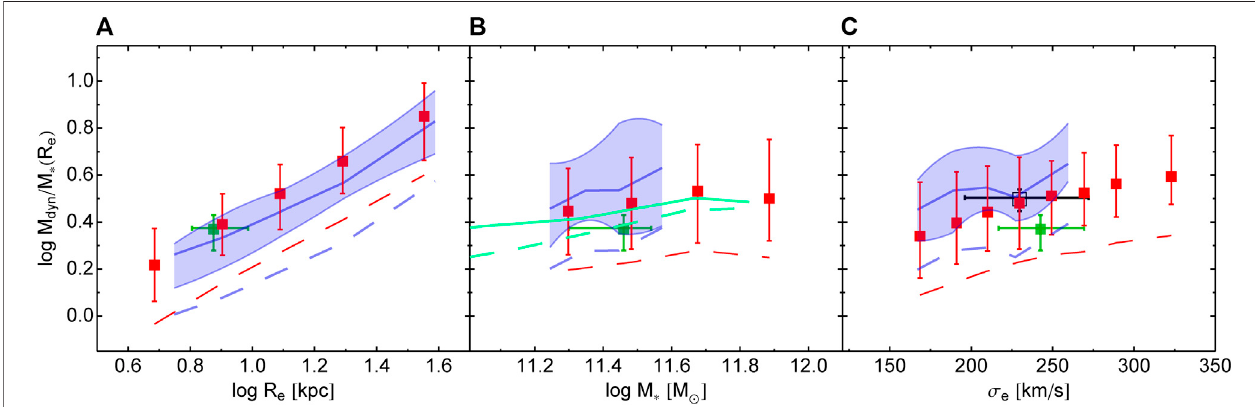
FIGURE1| Thetotal-to-stellarmassratio M dyn / M p withineffectiveradius, R e ,assumingaChabrierIMF,asafunctionof R e (A) ,totalstellarmass M p (B), andvelocity dispersionwithineffectiveradius σ e (C) .Linescorrespondtomedians,andshadedregionsorerrorbarstothe25 – 75thpercentile.Redsquareswitherrorbarsareforthe whole KiDS sample. Dark blue line and light blue region are for SPIDER galaxies with M p > 10 11.2 M ⊙ . Red and blue dashed lines are medians for KiDS and SPIDER galaxies adopting a Salpeter IMF. Green squares and error bars are for SLACS lenses from Auger et al. (2010a). The cyan lines in the middle panel are from IllustrisTNG simulated galaxies in Lovell et al. (2018): solid line is from the reference IllustrisTNG, while dashed one is for galaxies that, simulated within the full-physics IllustrisTNG simulation, are placed in their corresponding DM haloes simulated withinthe DM-onlysimulation. In the right panel, black open square and error bars are for the results obtained applying a Schwarzschild ’ s orbit superposition technique to ETGs in Thomas et al. (2011).